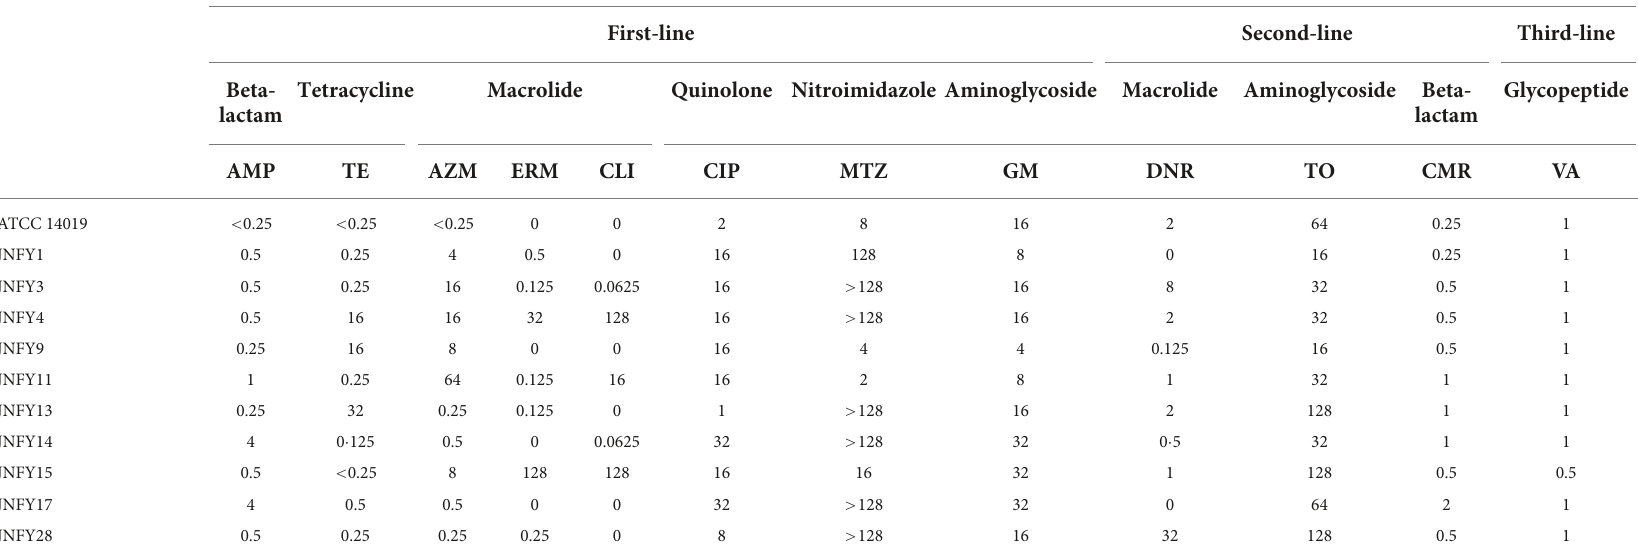
TABLE 4 MIC (minimum inhibitory concentration) of the Gardnerella strains on common antibiotics in clinic. Antibiotics-resistant